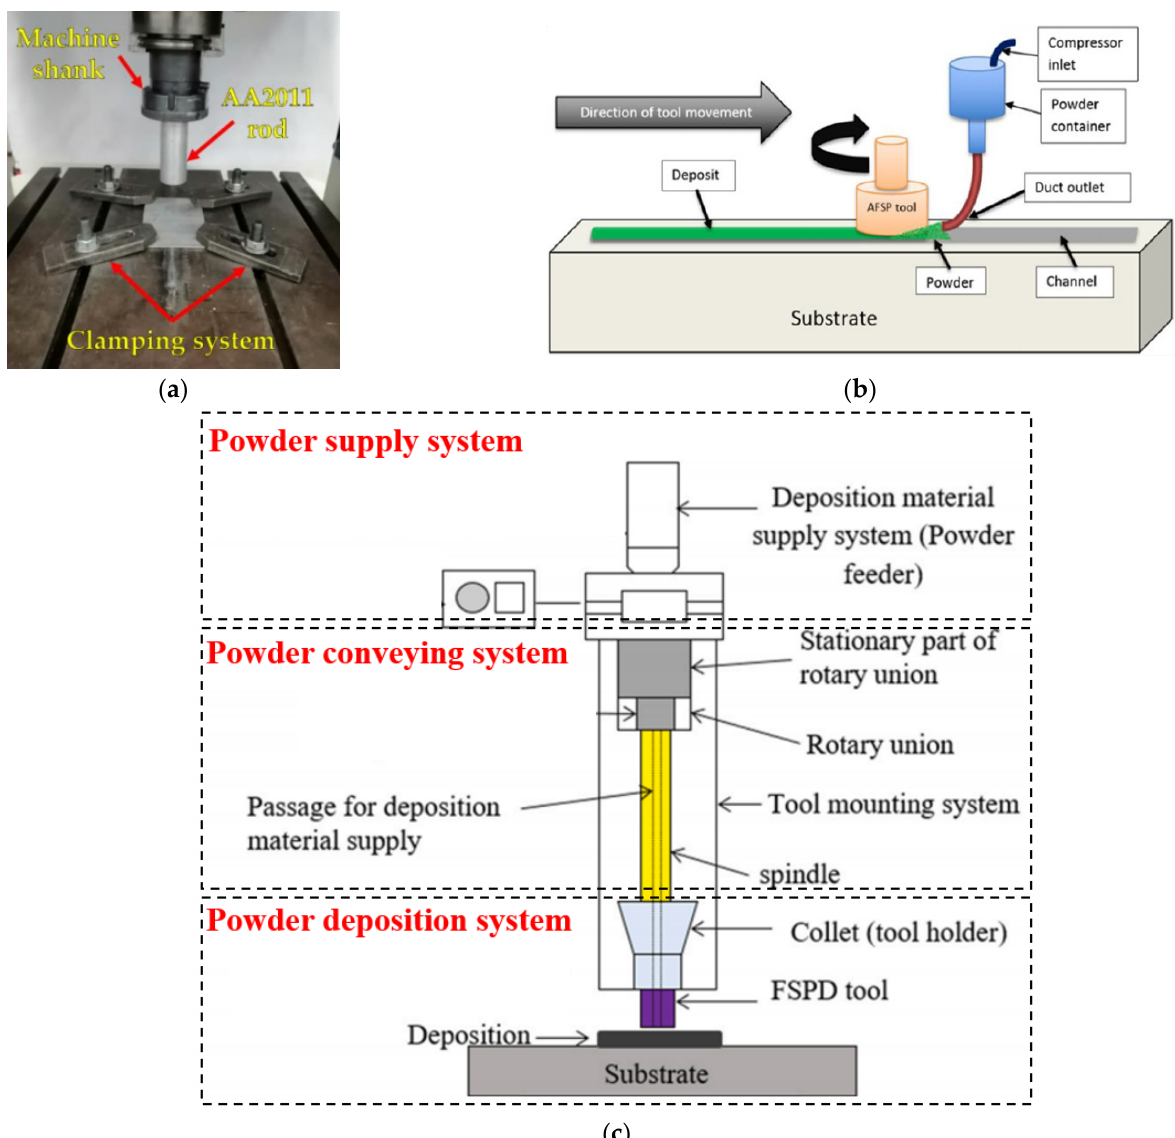
Figure 3. The improved machine used for the AFSD process. ( a ) The improved FSW machine [23]. ( b ) The improved machine based on milling machine [20]. ( c ) Developed apparatus for the AFSD of powder [24].